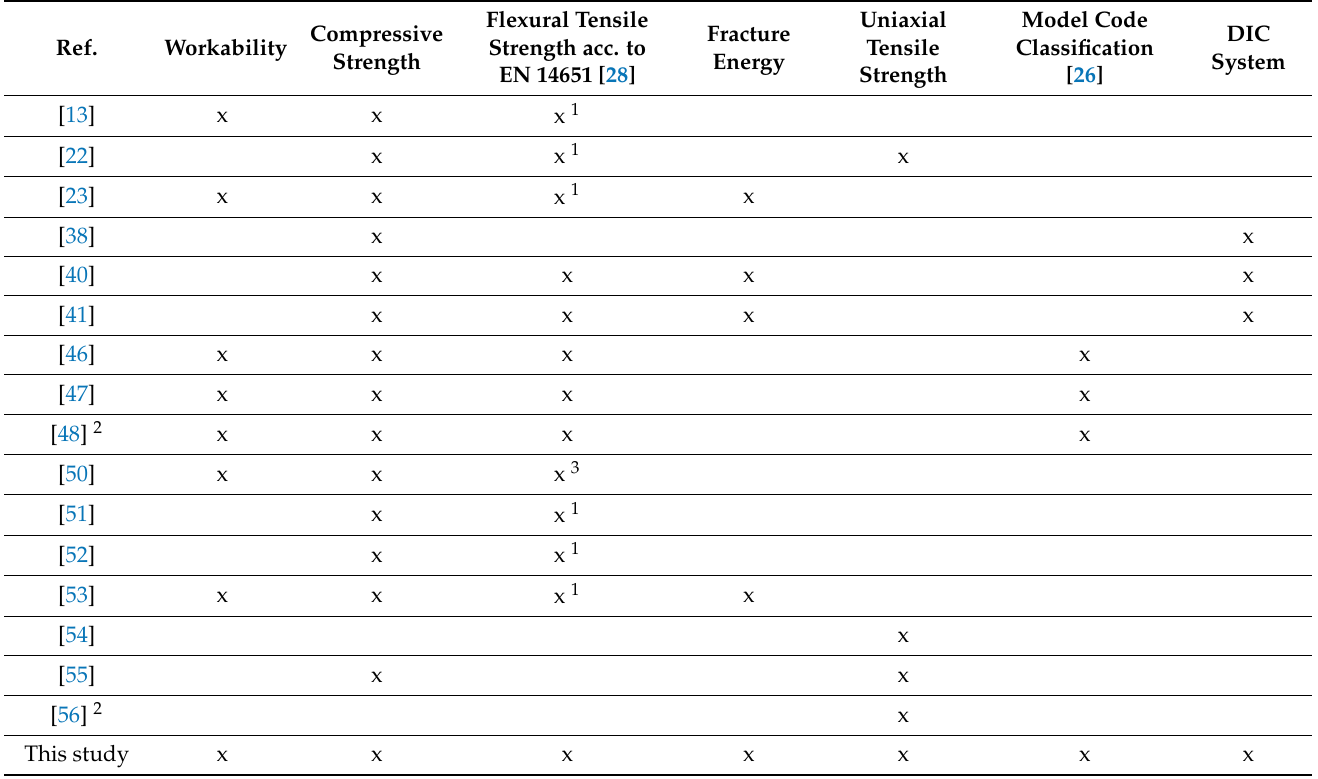
Table 1. Research about the influence of synthetic FRC.